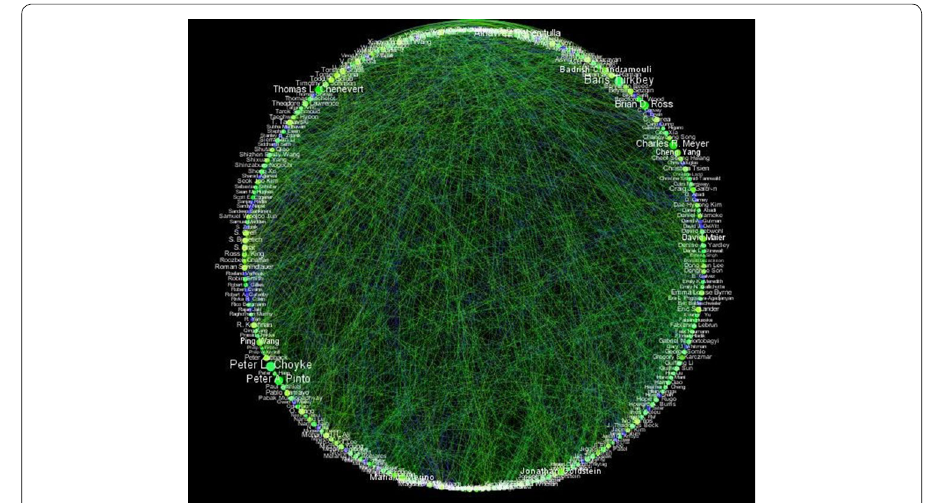
Fig. 16 Network of co-authors of scientific works cited by the patents